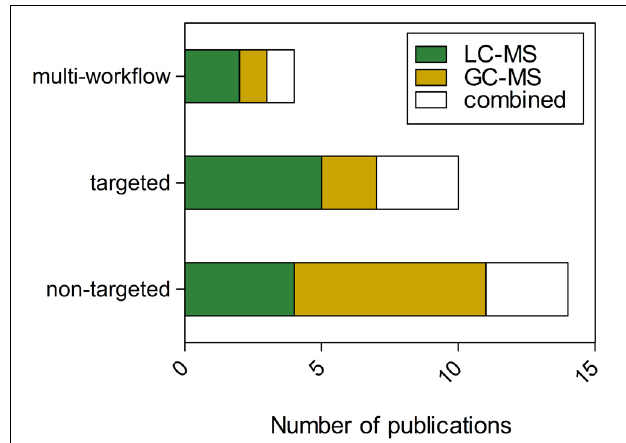
FIGURE 4 | Distribution of publications across workflows and platforms for MS-metabolomics related to plant immunity. “Combined” refers to studies that utilized LC and GC platforms. “Multi-workflow” refers to a publication that utilized both a targeted and non-targeted